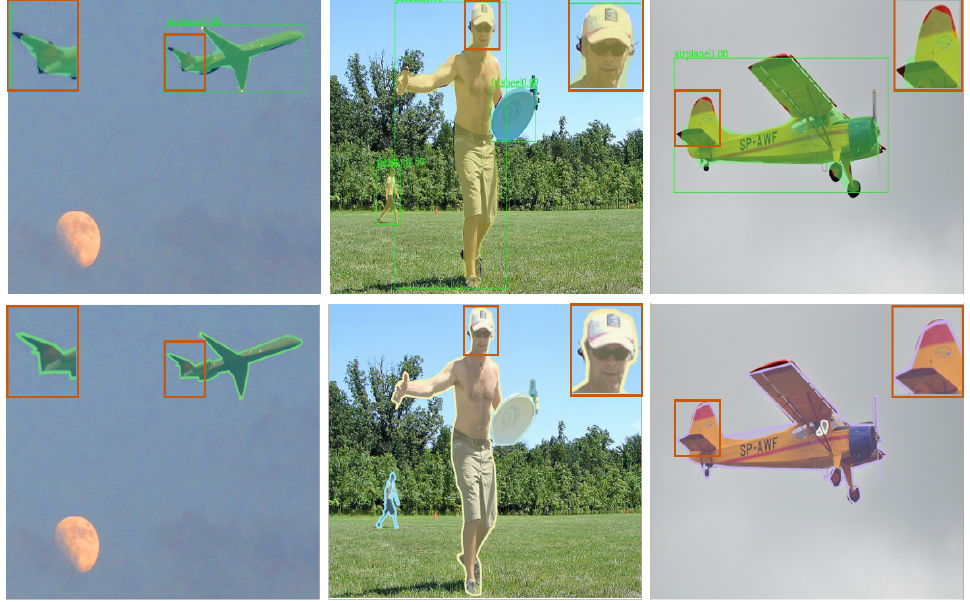
Figure 3. Display of predicted effects.The first row is the Mask R-CNN test sample. The second row is the